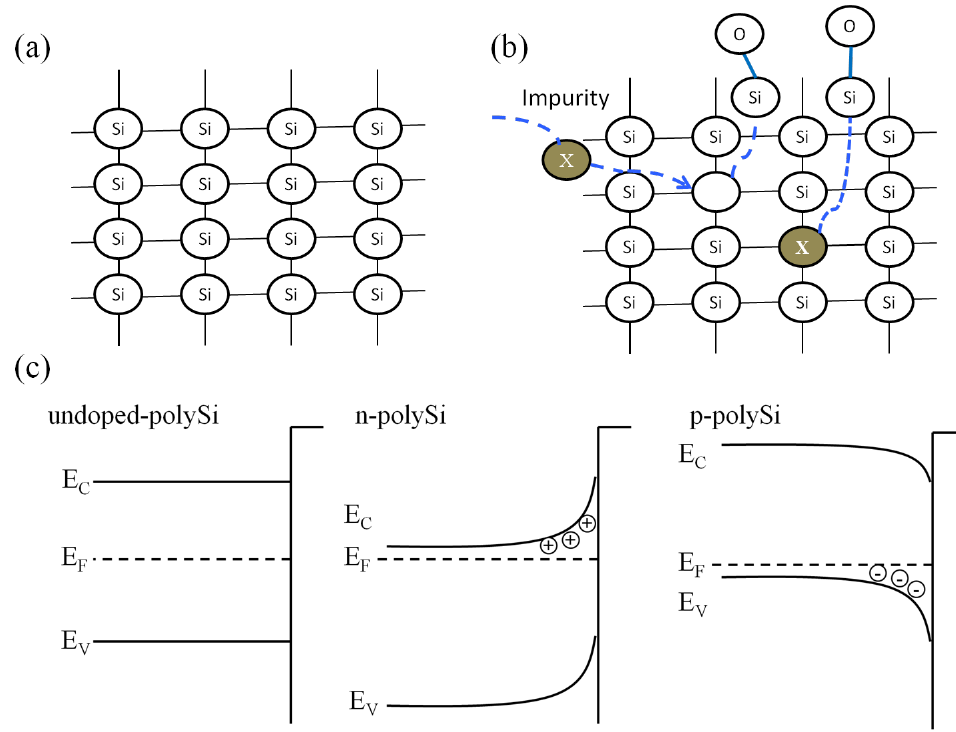
Figure 7. ( a ) and ( b ) Polysilicon lattice structure before and after ion implantation at a short range. ( c ) Schematic model for the doping effect during reactive plasma etching. Coulomb attraction in n-type and the Coulomb repulsion in p-type polysilicon play a major role in the field enhanced diffusion of a bromine atom.